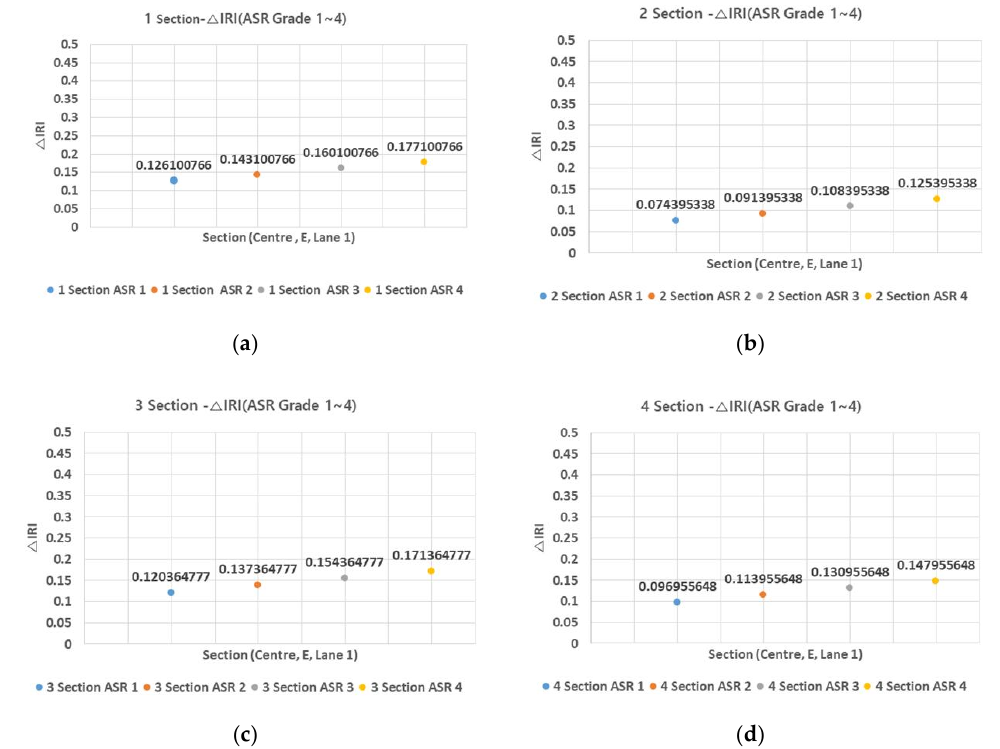
Figure 3. Section–ΔIRI relationship (ASR grade 1–4) ( a ) 1 section; ( b ) 2 section; ( c ) 3 section; and ( d ) 4